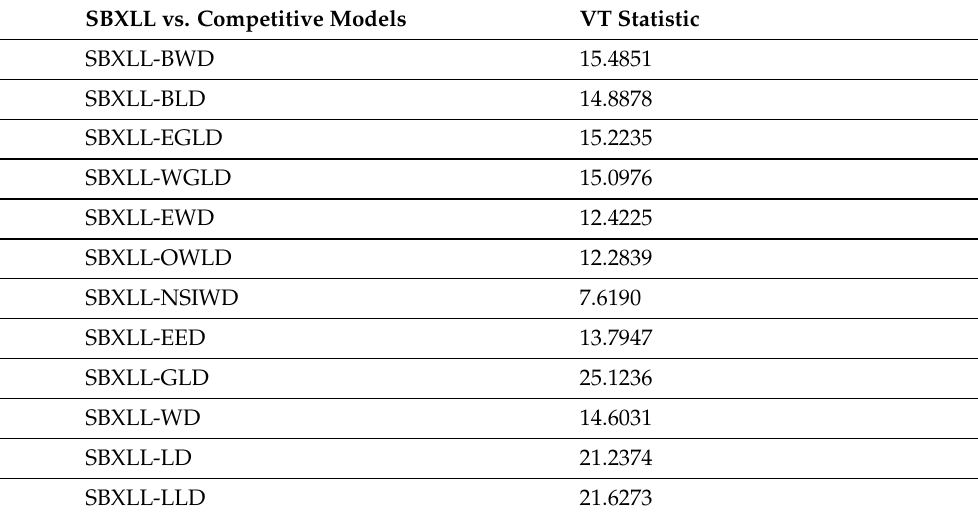
Table 19. Vuong’s test applied on data set III at Z 0.05 = 1.6495.